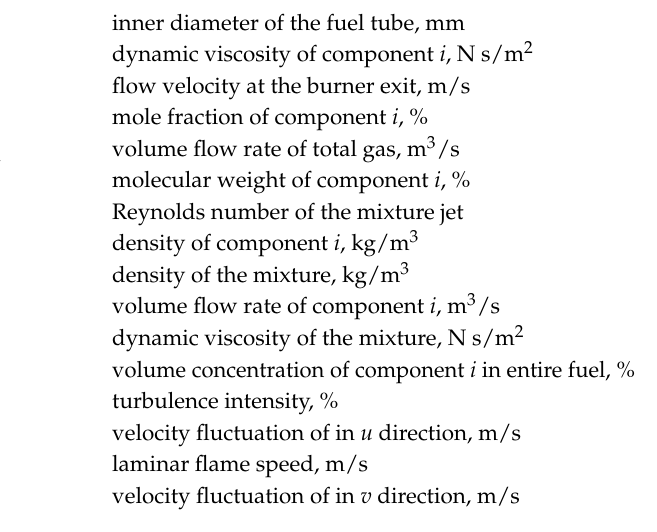
Table S1. Combination parameters of blended fuel at a constant volume flow rate V total = 11.78 L/min for typical flame patterns. Table S2. Volume concentration of each fuel in the entire fuel